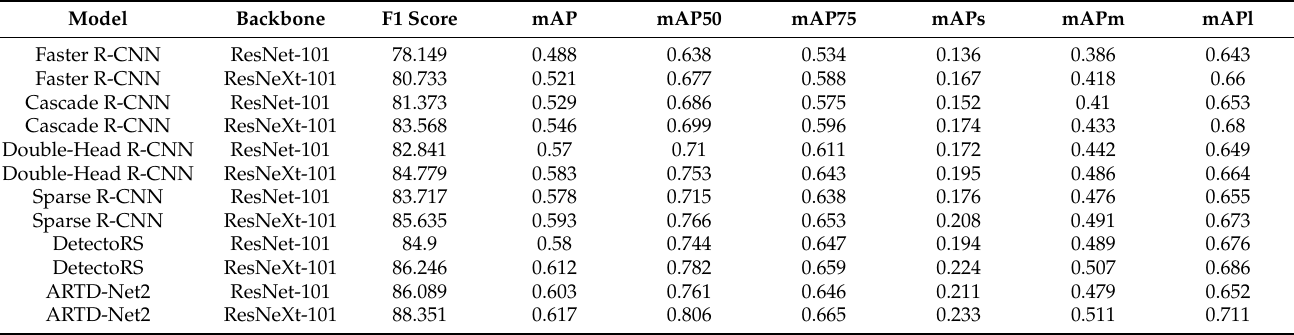
Table 5. Comparison between ARTD-Net2 and other multi-stage deep learning